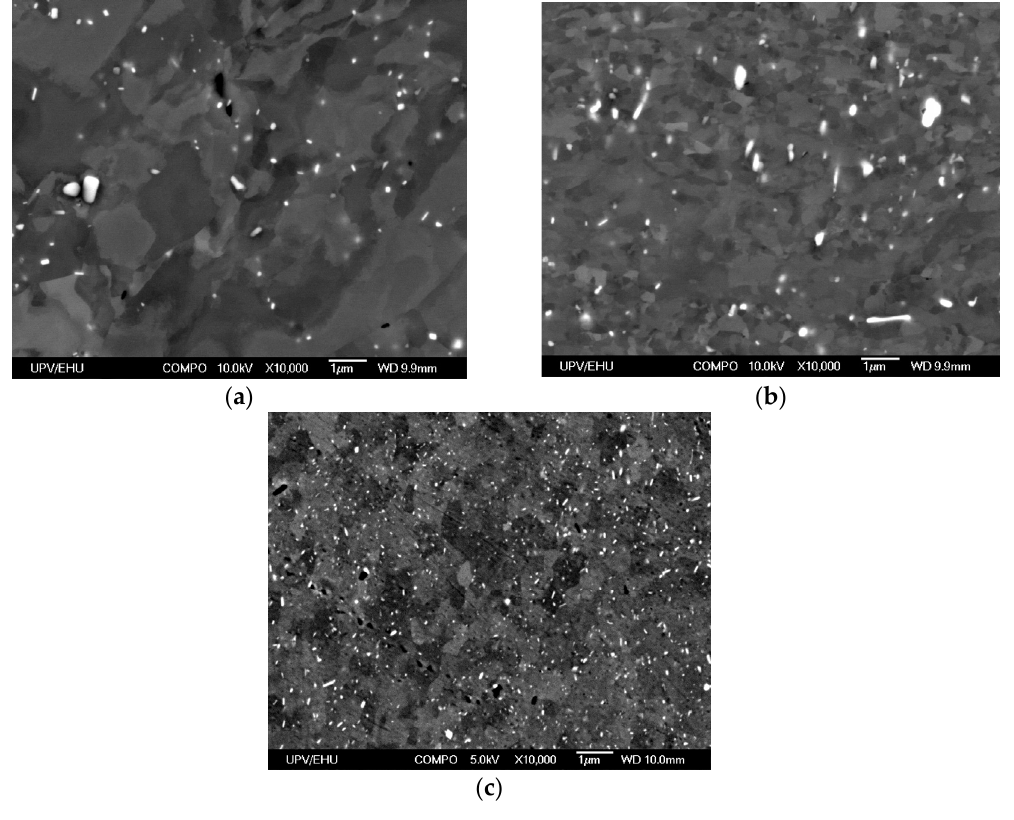
Figure 13. SEM micrographs of different AA5083 states forged at 250 °C: ( a ) AA5083 at N0; ( b ) AA5083 at N2; ( c ) AA5083 at N2 + flash. Table 11. RMSE of each flow rule obtained for AA3103 in relation to the experimental curve (MPa).